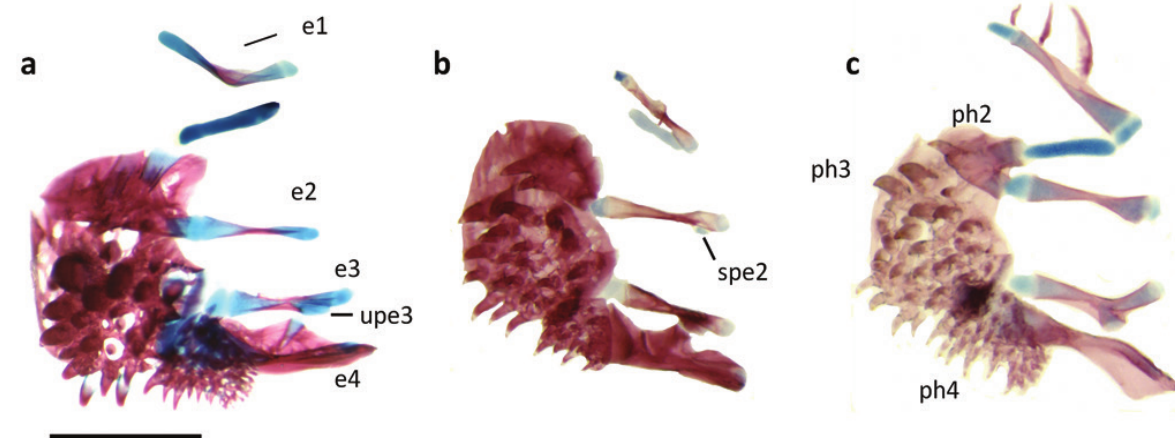
Fig. 4. Ventral view of dorsal gill arches of a. Pterolebias longipinnis , b. Cynopoecilus melanotaenia , c. Austrolebias juanlangi ; e = epibranchial series, ph = pharyngobranchial series, spe2 = epibranchial subdistal process, upe3 = uncinate process of epibranchial 3. Scale bar = 1 mm.